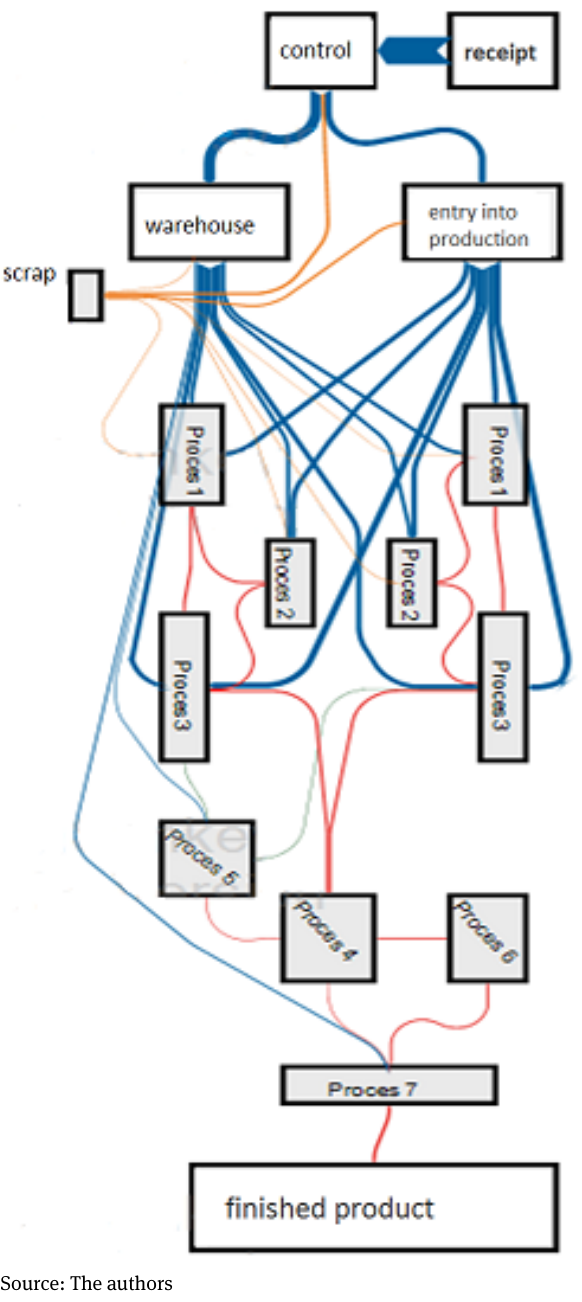
Figure 3: Sankey diagram